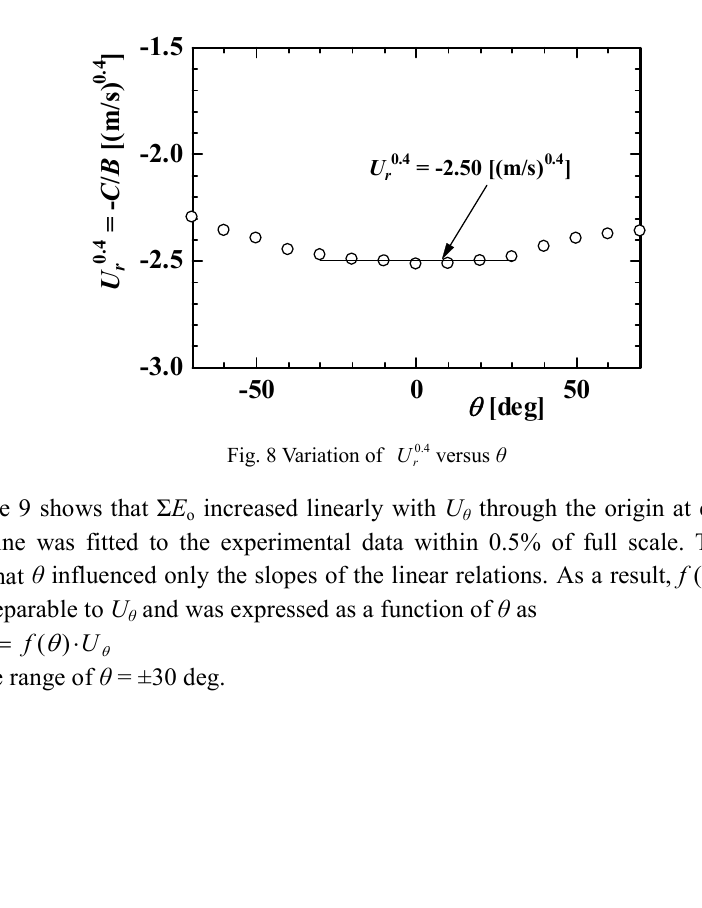
E Σ for 0.4 U HW θ